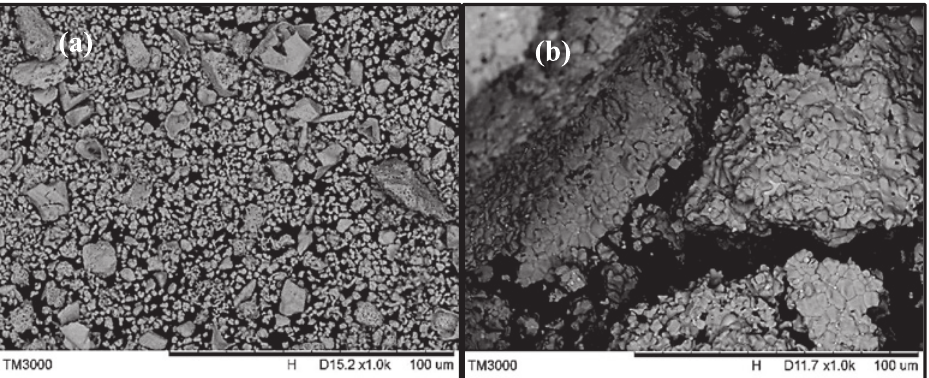
Fig. 4: SEM images of manganese oxide: (a) before reduction (b) after reduction